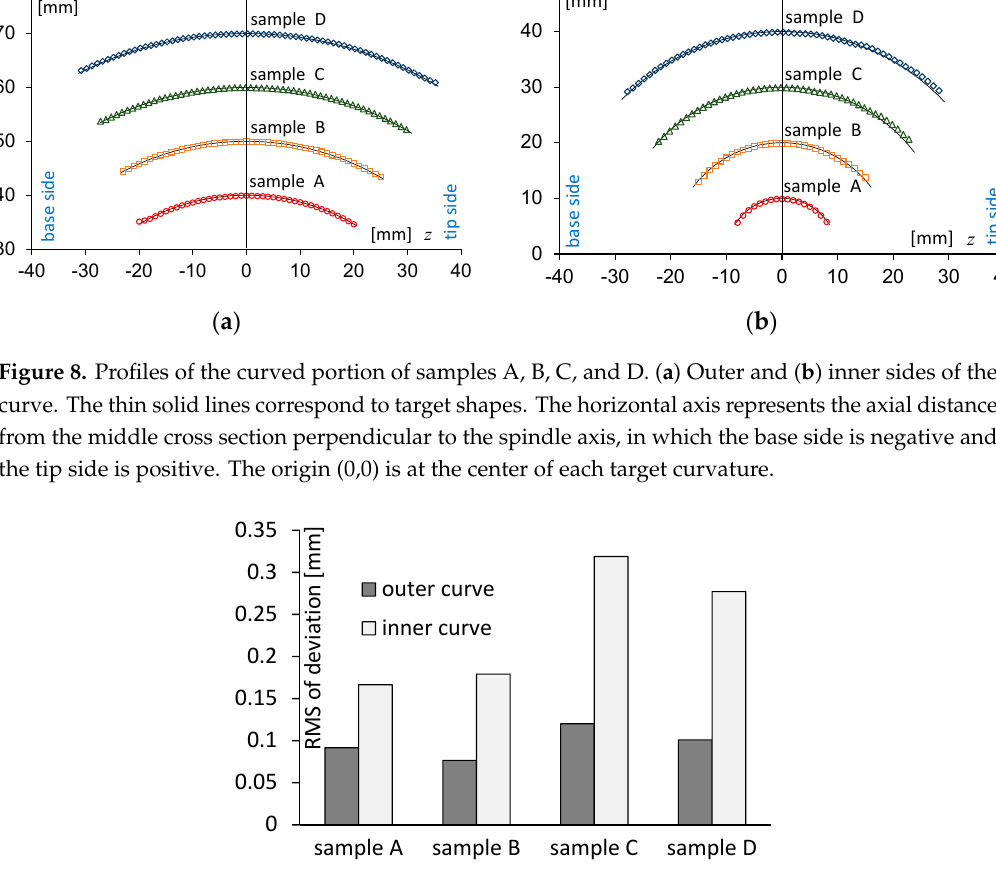
Figure 9. Root mean square of the deviation from the target shape.